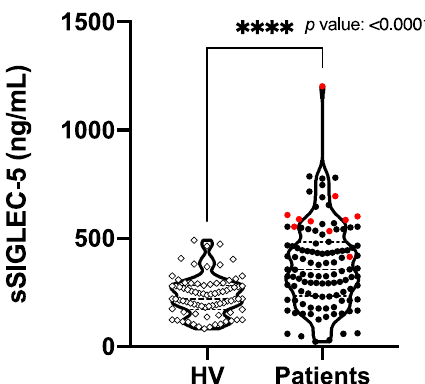
sPD-L1) commonly assayed for CRC immunotherapies did not show significant differences in plasma concentration between the patients with CRC ( n = 114) and randomly chosen HVs ( n = 30), as shown in Figure S1.